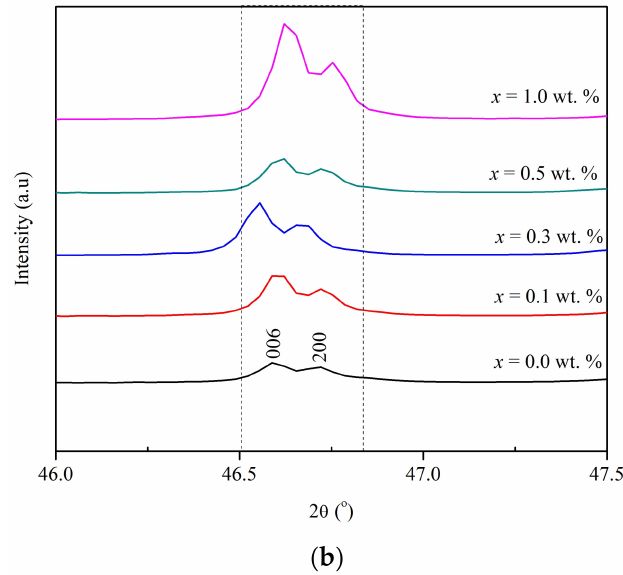
Figure 2. ( a ) X-ray diffraction analysis of Y123 added with graphene nanoparticles by the thermal treatment method. ( b ) The XRD patterns of the peaks corresponding to the (006) and (200) plane of the Y123 peaks in the Y123 + x wt.% graphene